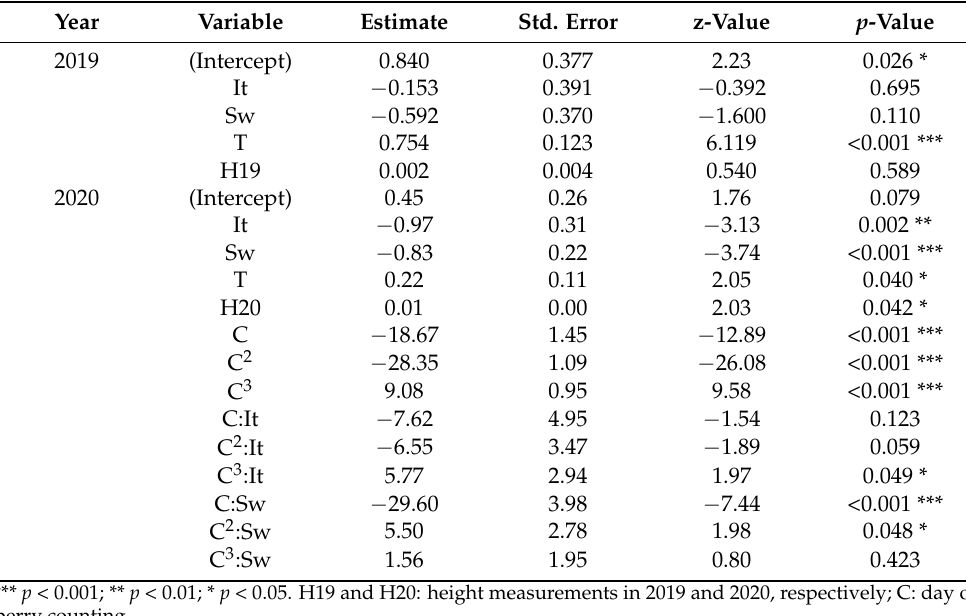
Table 3. Statistical analysis of the mature berry counts in 2019 and 2020. In the model, the Belgian provenance is the standard to which the Italian (It) and Swedish (Sw) provenances are compared, and for the treatment in 2018 (T), the control is the standard to which the water limitation is compared.